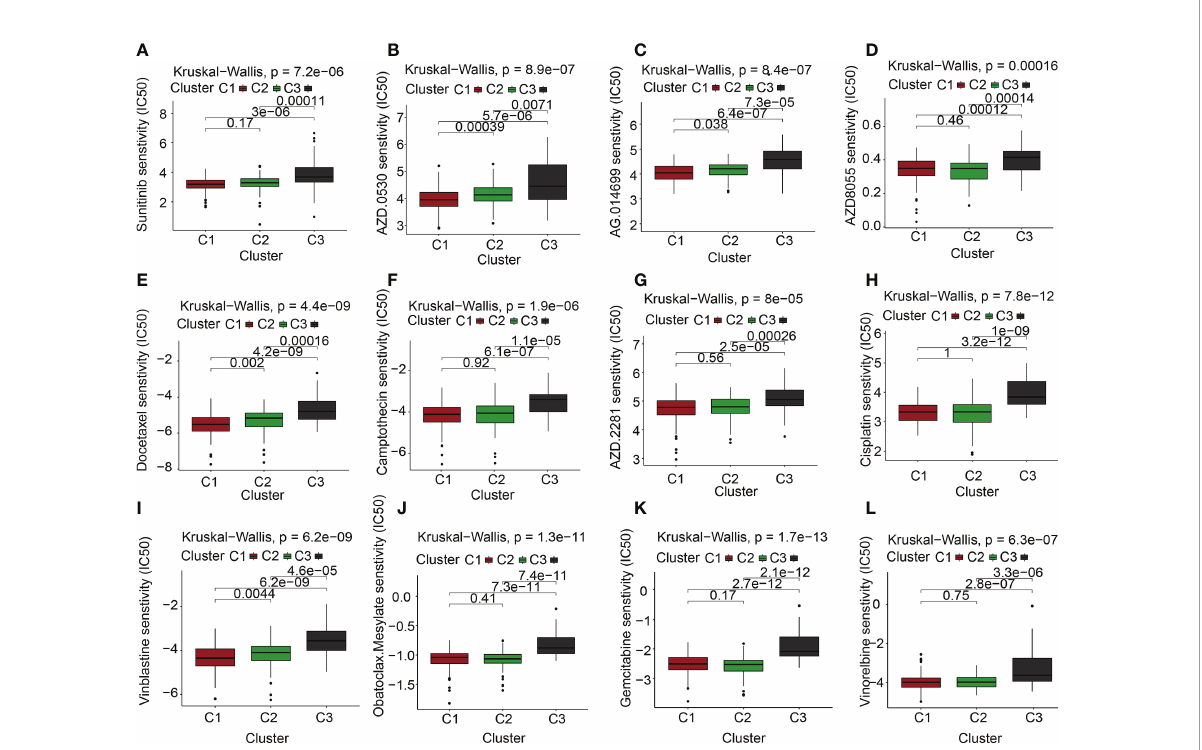
FIGURE 6 The link between ECM clusters and drug sensitivity. The estimated IC50 box plots for 12 kinds of commonly used chemotherapeutic drugs are conducted in (A-L) for cluster 1 (yellow), cluster 2 (blue), and cluster 3 (red). The 12 types of chemotherapeutic agents are AZD0530